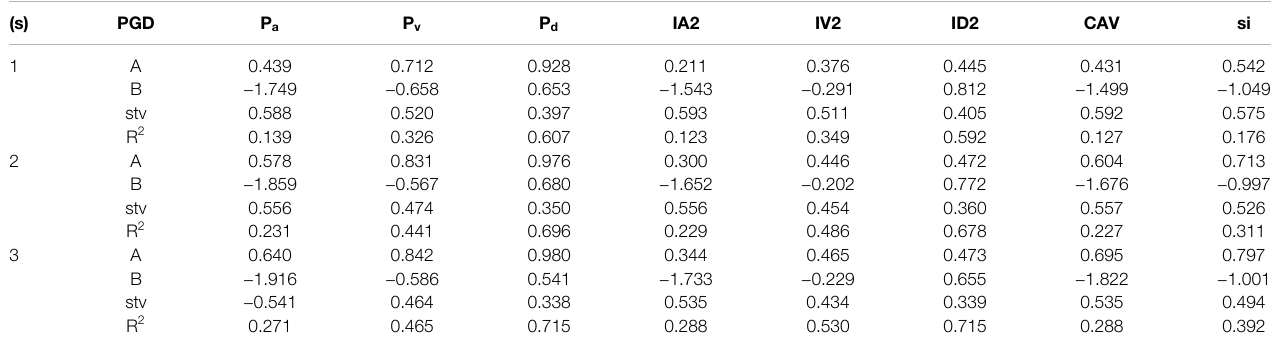
TABLE 4 | Regression coef fi cients of the characteristic parameters and PGD.